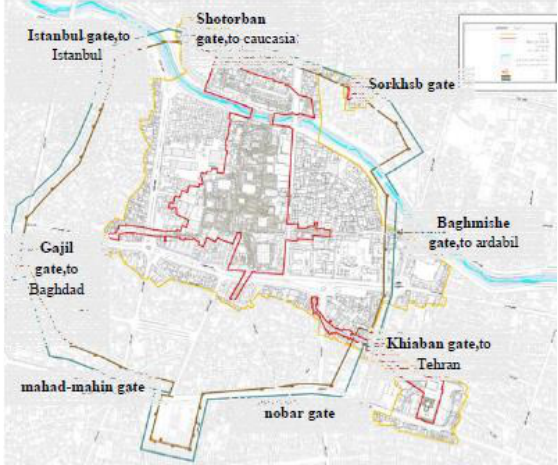
Figure 22. The Location of Historical Gates of Tabriz Old City (UNESCO,